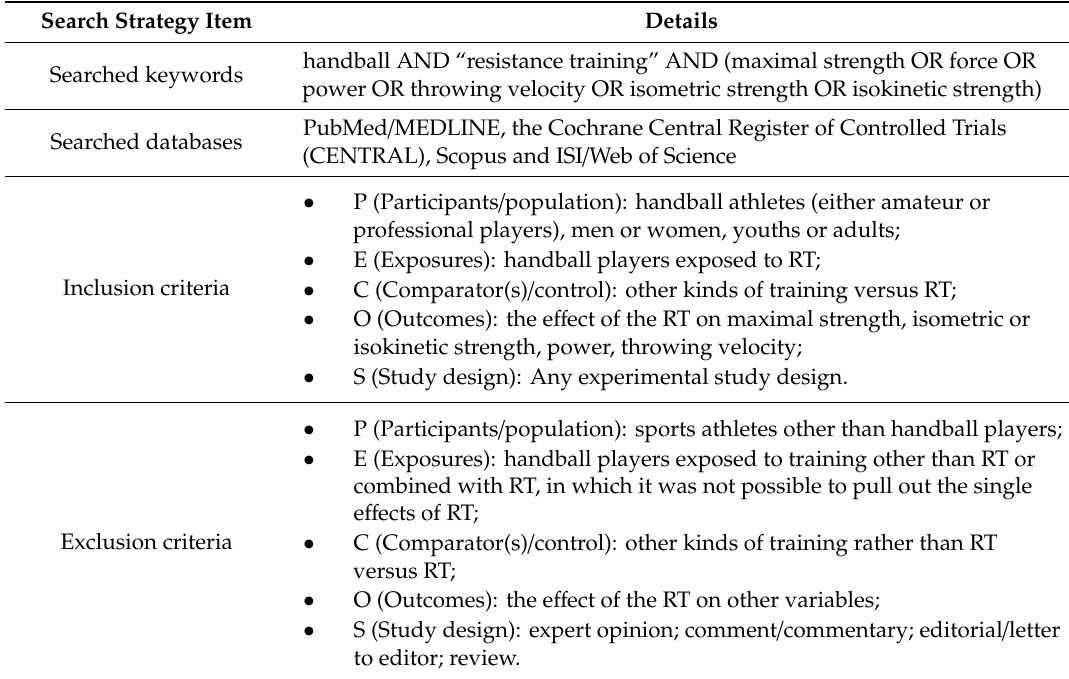
Table 1. Search strategy adopted in the present systematic review and